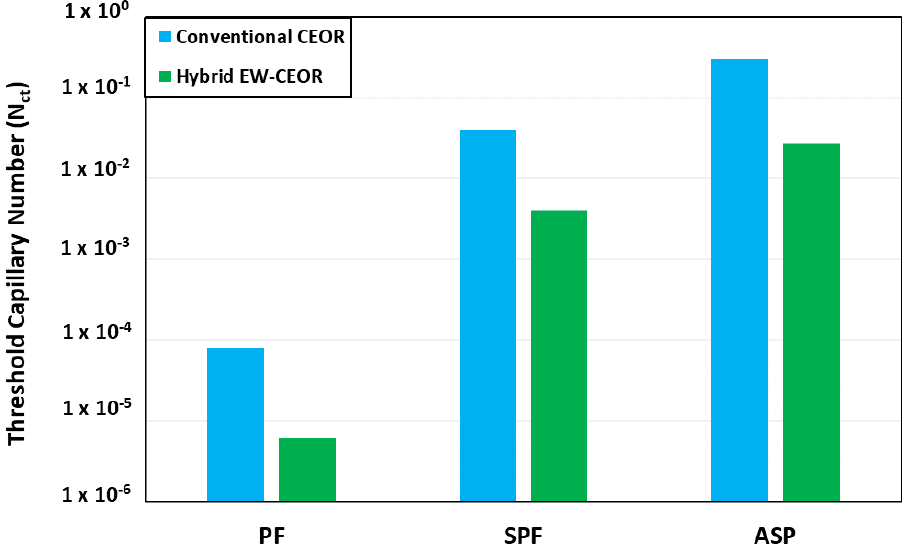
Figure 7. Comparison of threshold capillary numbers of hybrid EW/CEOR methods with conven- tional ones.